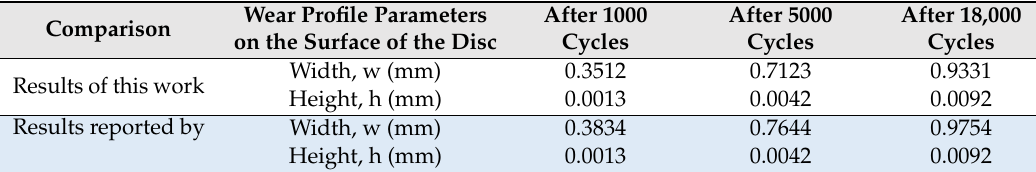
Figure 2. The distribution of displacement in the Y-axis (in meters) representing material removal from the surface of the disc under a normal force of 1200 N and a sliding amplitude of 10 µm after 18,000 cycles of fretting wear. Table 1. The width and height of the wear profile for the disc after various fretting wear test cycles. A comparison between the computational results of this work and those presented by Ding et al. [28].